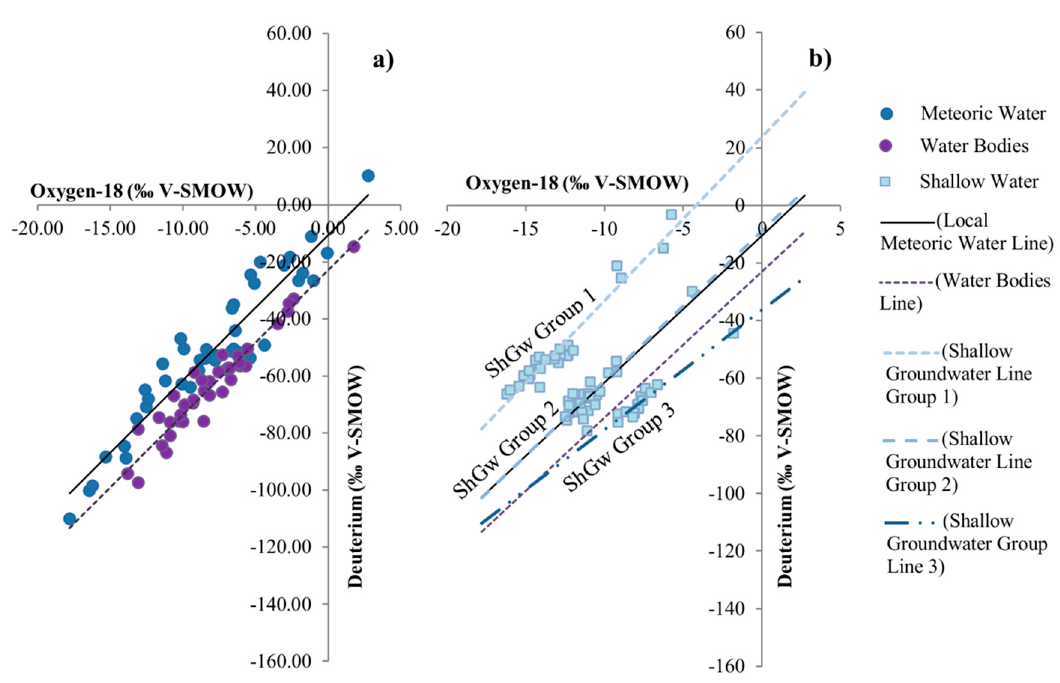
Figure 6. Stable isotopic composition of meteoric water, surface water ( a ); and sampled ShGw, LMWL (local meteoric water line), and SWL (surface water line) ( b ).